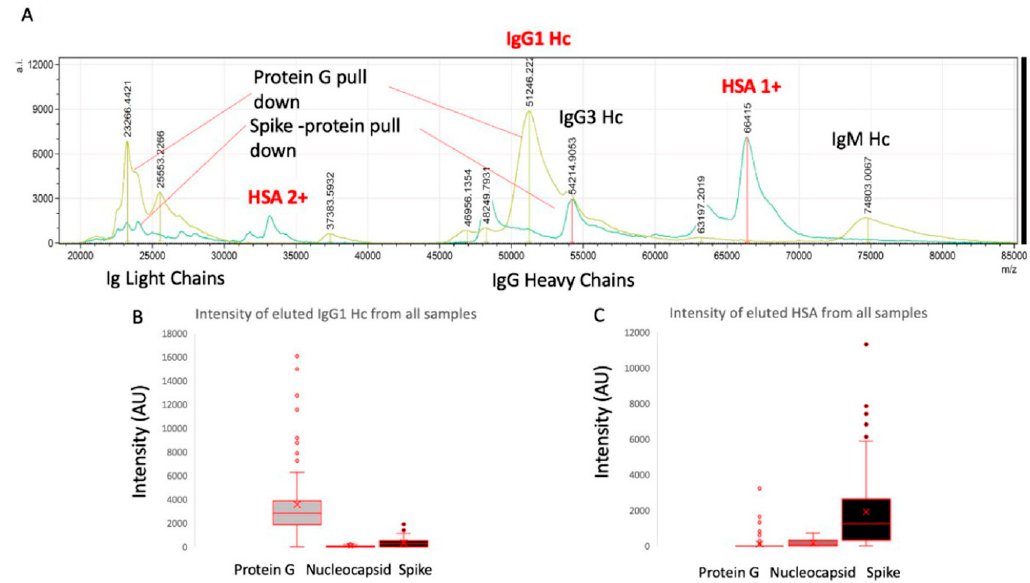
Figure 2. Example mass spectra of eluted sample from protein G bead–captured proteins overlaid with spike protein–captured plasma proteins (panel A ) and relative intensities of IgG1 heavy chains (IgG 1 Hc) recovered from the same samples by protein G, nucleocapsid and stabilised spike protein (panel B ) versus HSA (single: 1+; doubly charged: 2+) recovered from the same samples by protein G, nucleocapsid and stabilised spike protein (panel C ).